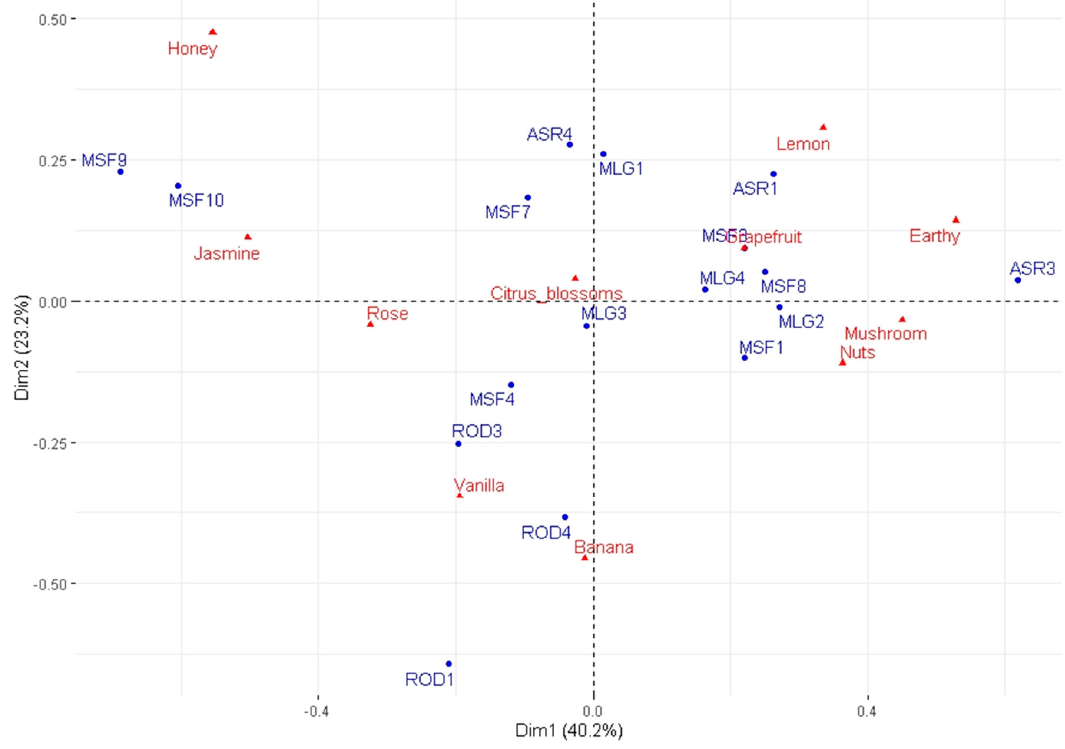
Figure 2. The two dimensions (symmetrical plot) of the correspondence analysis in the product and descriptor space.